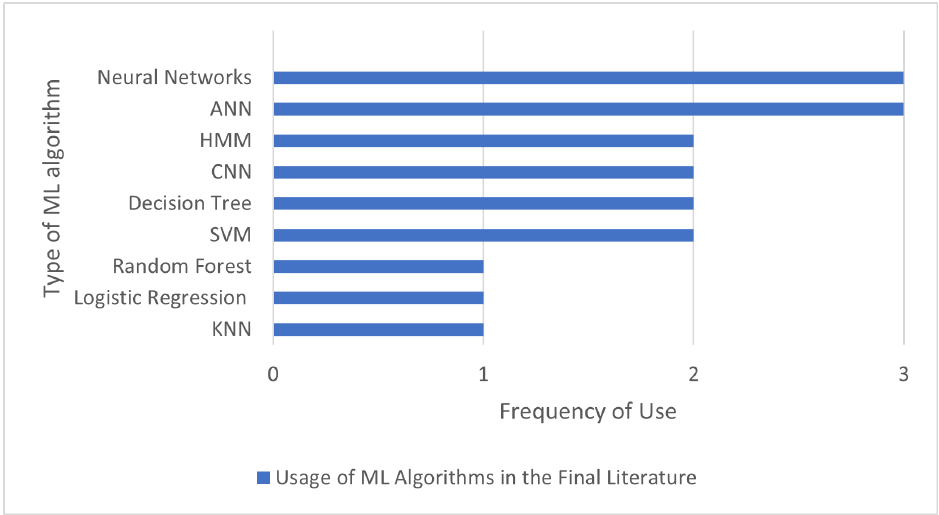
Figure 6. The number of times each algorithm appeared in the final